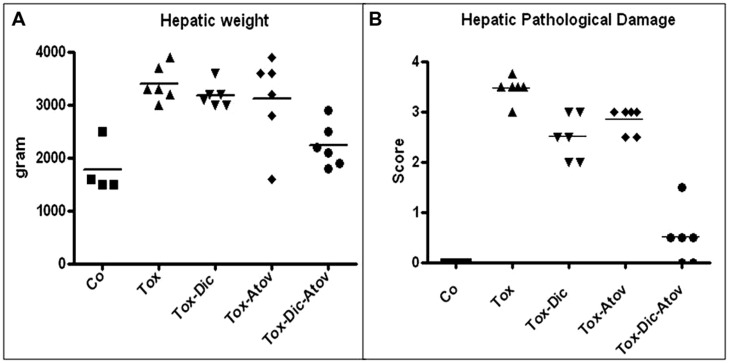
(A) Hepatic weight distribution in Toxoplasma (Tox) infected (p < 0.001) compared to diclazuril (Dic) monotherapy (p < 0.01), atovaquone (Atov) monotherapy and combined diclazuirl plus atovaquone (Dic + Atov) therapy (p < 0.001) and normal sham controls (Co). (B) Hepatic pathological score distribution in Toxoplasma (Tox) infected dams (p < 0.001) compared to diclazuril (Dic) monotherapy (p < 0.01), atovaquone (Atov) monotherapy (p < 0.05), combination diclazuirl plus atovaquone (Dic + Atov) therapy (p < 0.001) and normal sham controls (Co). Pathological slides were stained with H&E. (n = 6–8/group).